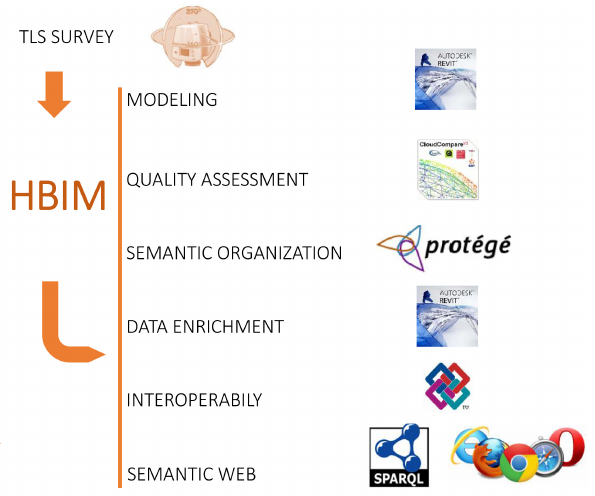
Figure 3. The procedure for obtaining HBIM devoted to restora- tion project: tools, steps and software.